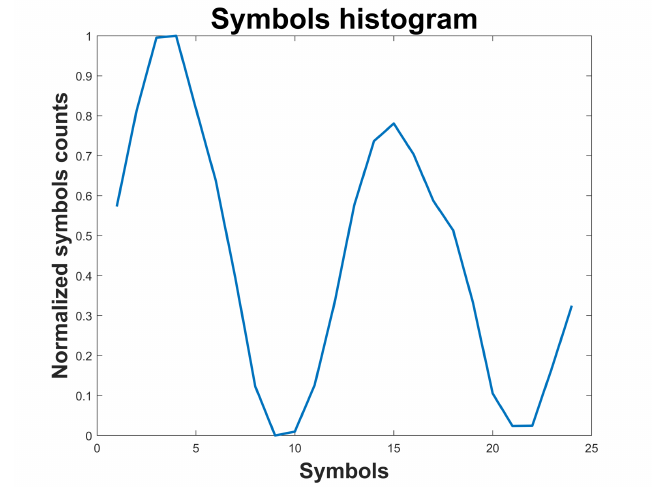
Figure 16. Histogram of symbols for the faulty case P5 of the reciprocating